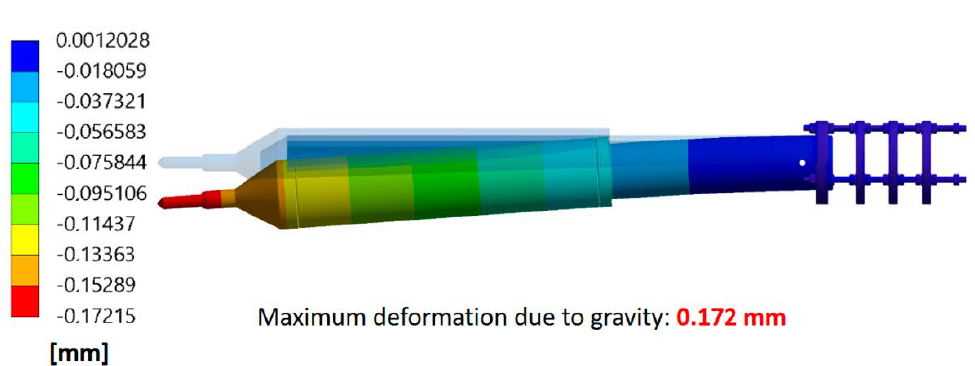
Figure 19. Deformation for three additional stiffening rings (case 2).